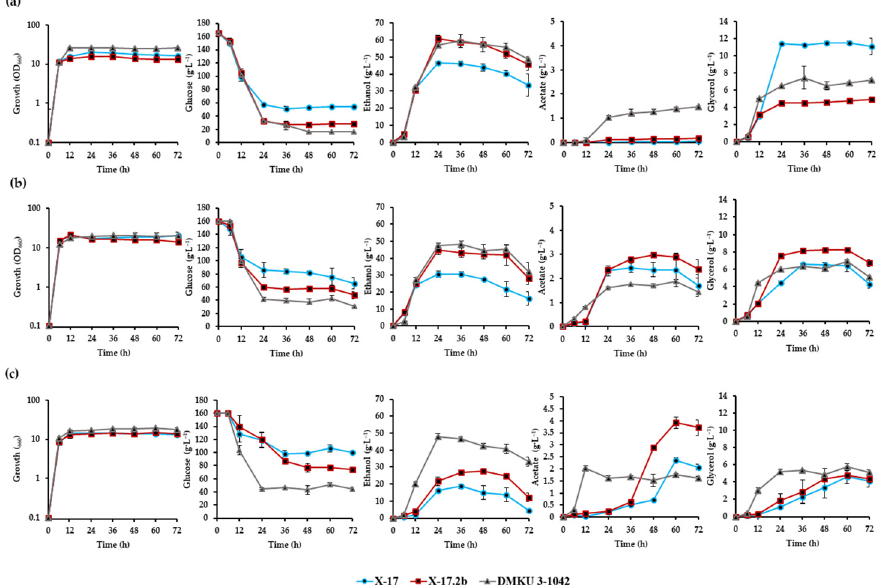
Figure 2. Growth and metabolite profiles of C. tropiclis X-17 ( filled circles ), adapted strain C. tropicalis X-17.2b ( filled squares ) and K. marxianus DMKU 3-1042 ( filled triangles ). Cells are grown in YP media containing 160 g · L − 1 glucose at ( a ) 37 °C, ( b ) 40 °C and ( c ) 42 °C under a shaking condition at 100 rpm, and samples were taken at 6 h and every 12 h until 72 h of incubation. Bars represent the ±SD of values from experiments performed in triplicate.